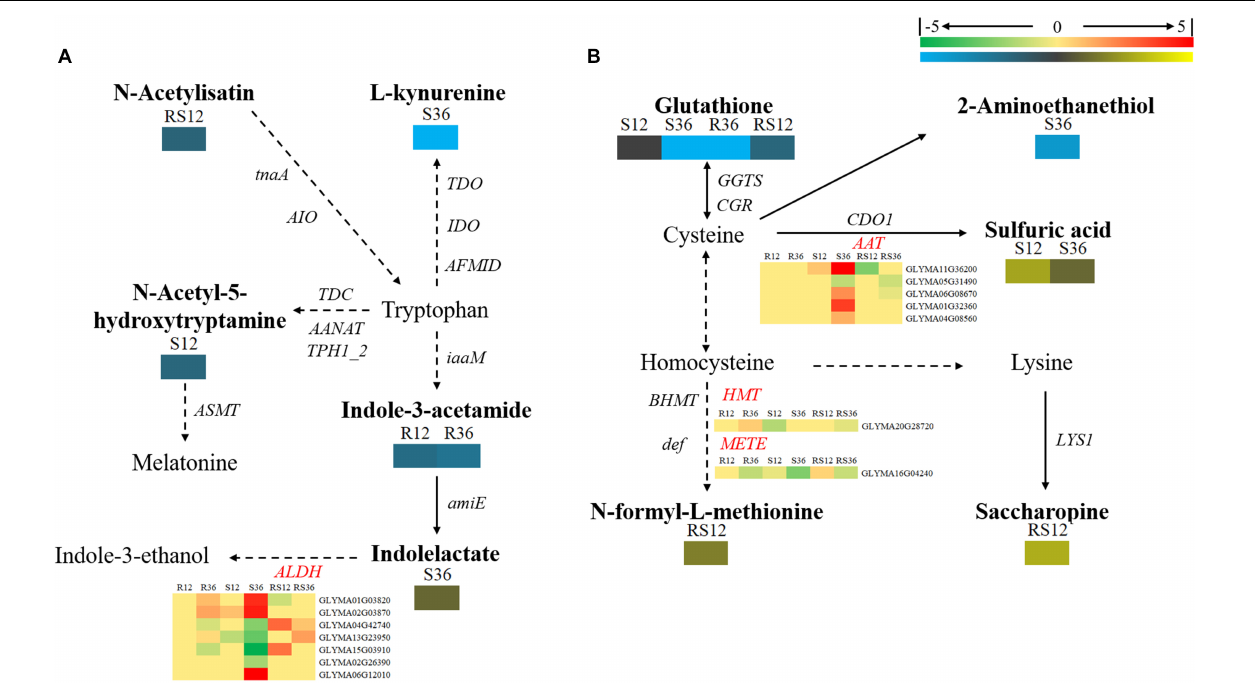
FIGURE 5 | Brief diagram of amino acid metabolism pathways with related DEGs and DAMs. (A) Pathway of tryptophan metabolism. (B) Pathways of cysteine and lysine metabolism. DAMs are in bold black fonts. No significantly differentially accumulated metabolites are in black fonts, unidentified metabolites are in gray fonts, and the abbreviations of gene names are in italics. The log 2 Foldchange was colored using Cluster 3.0 (red for upregulated DEGs, green for downregulated DEGs, yellow for upregulated DAMs, and blue for downregulated DAMs), and the vertical columns represent R12, R36, S12, S36, RS12 and RS36, from left to right. R12: R-12h-IN vs. R-12h-CK; R36: R-36h-IN vs. R-36h-CK; S12: S-12h-IN vs. S-12h-CK; S36: S-36h-IN vs. S-36h-CK; RS12: R-12h-CK vs. S-12h-CK; and RS36: R-36h-CK vs. S-36h-CK. IN, inoculated; CK, control check. A color bar is in the upper right